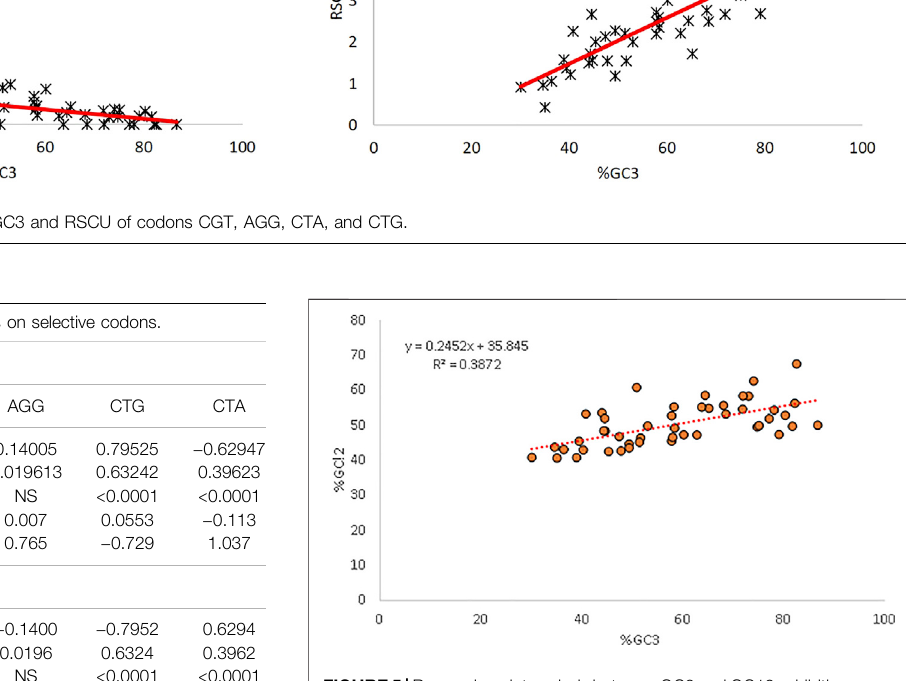
FIGURE5| RegressionplotanalysisbetweenGC3andGC12exhibiting the mutational and selection